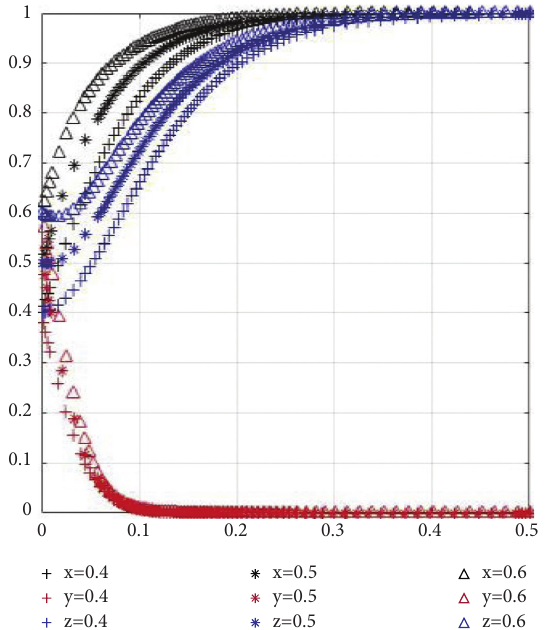
Figure 1: The evolution result of the simultaneous change of participation